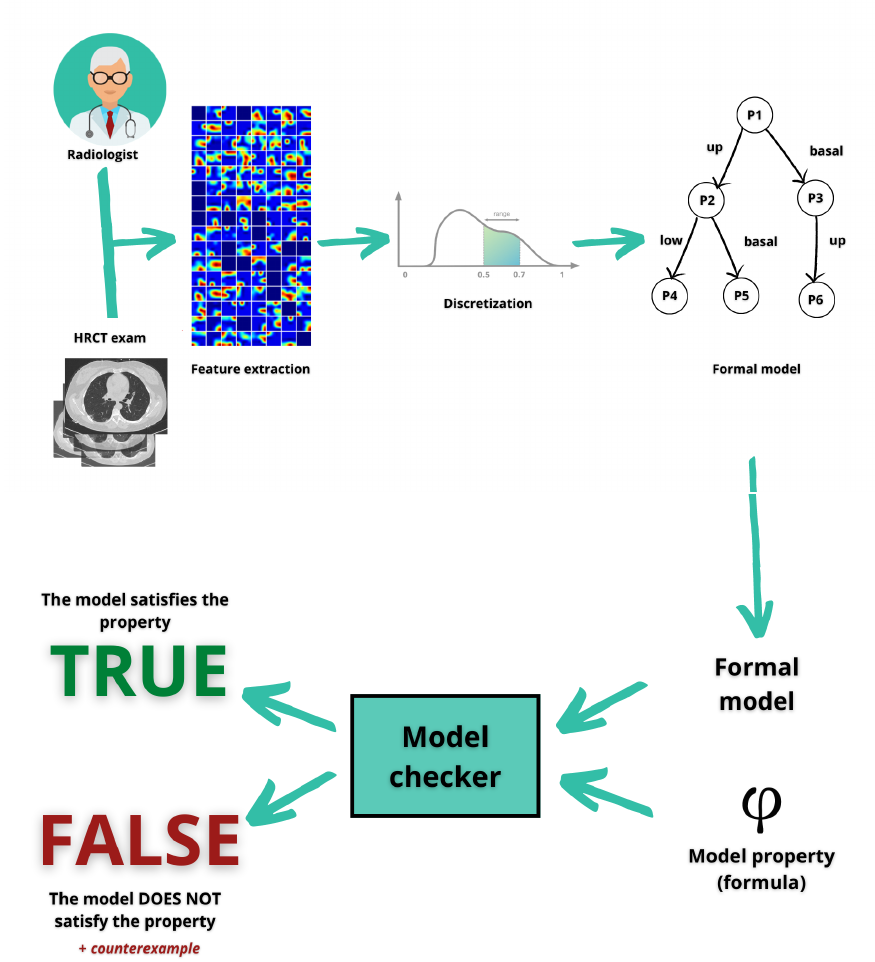
Figure 1. The proposed approach per automatic COVID-19 diagnosis. Starting by the medical imaging, the radiomic features are discretised and the formal model is generated, which will be evaluated by the final model-checking